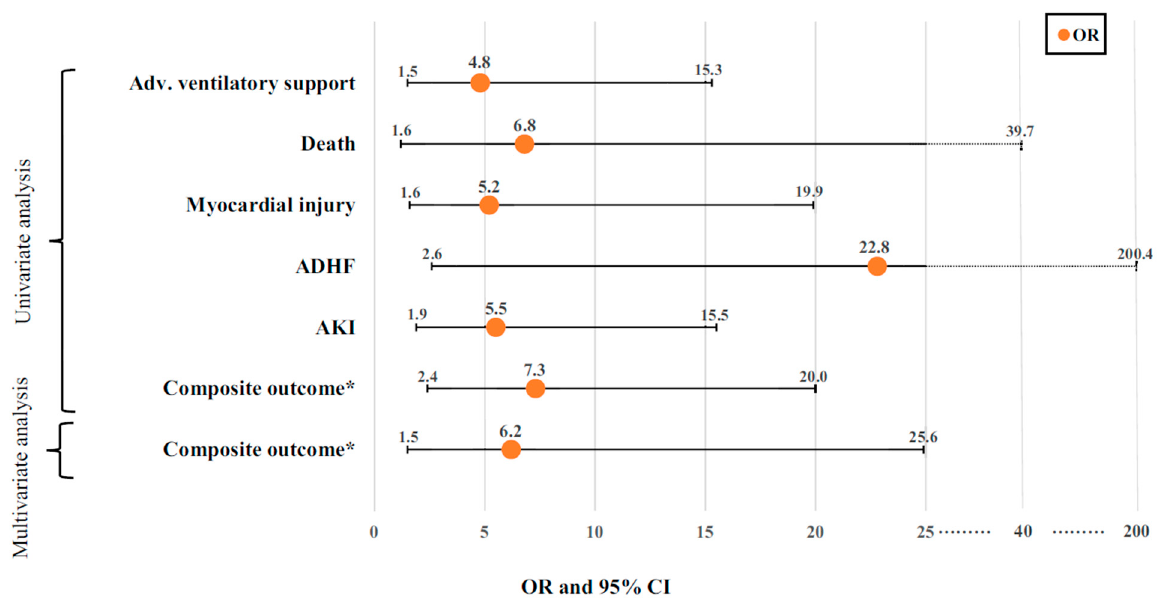
Figure 3. Significant associations (odds ratio and 95% confidence interval) between abnormal echocardiogram and serious adverse events (endpoints) * The primary endpoint was defined as a composite endpoint of in-hospital death, mechanical ventilation, shock and acute decompensated heart failure. Abbreviations: ADHF, acute decompensated heart failure; Adv., advanced; AKI, acute kid- ney injury; OR, odds ratio. Reprinted from the Canadian Journal of Cardiology , Volume 38, Issue 3, Dadon et al., The Utility of Handheld Cardiac and Lung Ultrasound in Predicting Outcomes of Hos- pitalised Patients With COVID-19, Pages 338–346, 2022, [40] with permission from Elsevier.